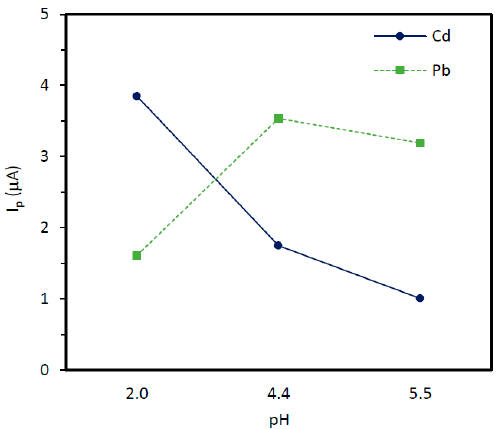
Figure 2. Peak current evolution of 30 ng/mL Cd(II) and 30 ng/mL Pb at the Bi SP SPE at different pHs. Experimental conditions: Deposition time: 120 s; deposition potential: − 1.2 V; stirring rate: 600